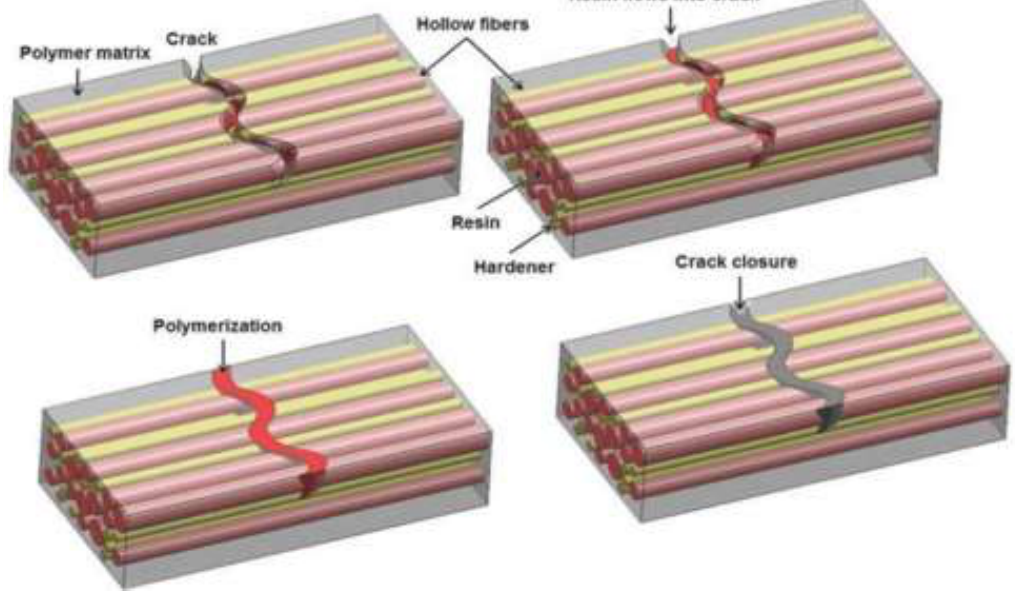
Figure 2. Self-healing perception with hollow fibers.